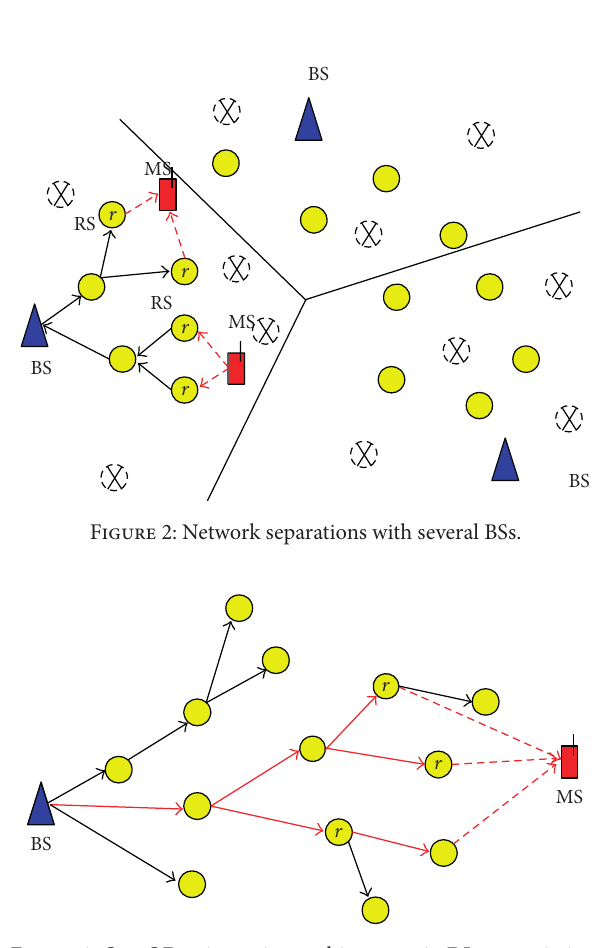
Figure 3: One OD pair routing multicast tree in DL